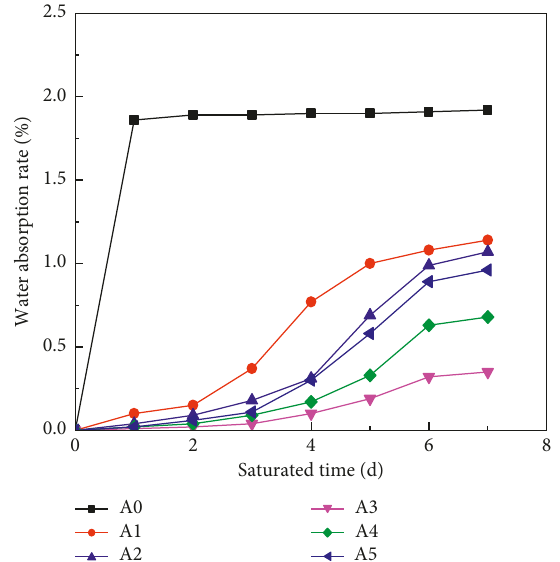
Figure 10: Curve of water absorption of the sample with im- mersion